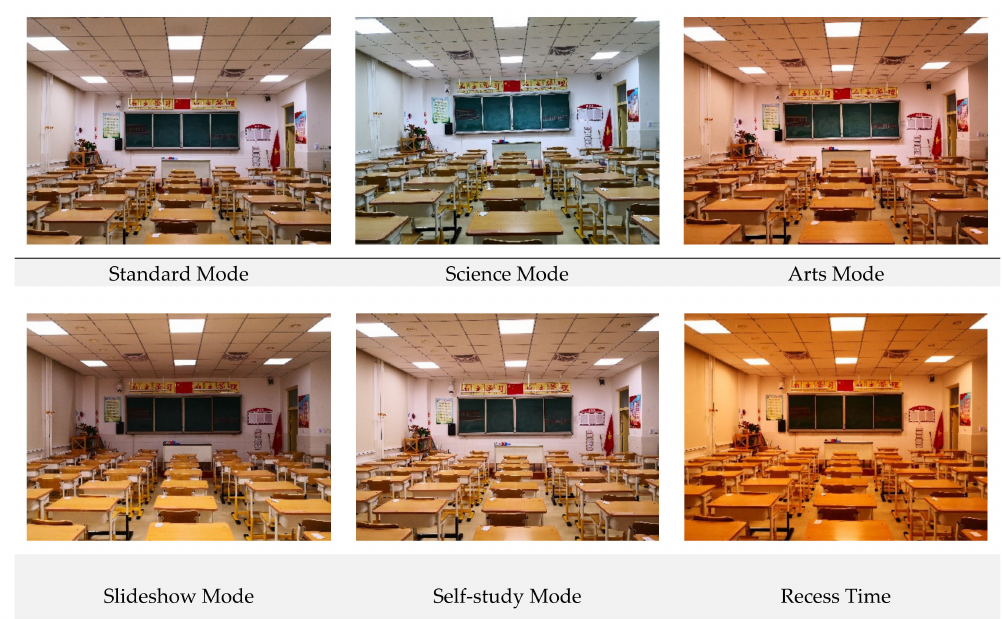
Figure 21. The six lighting modes applied in this